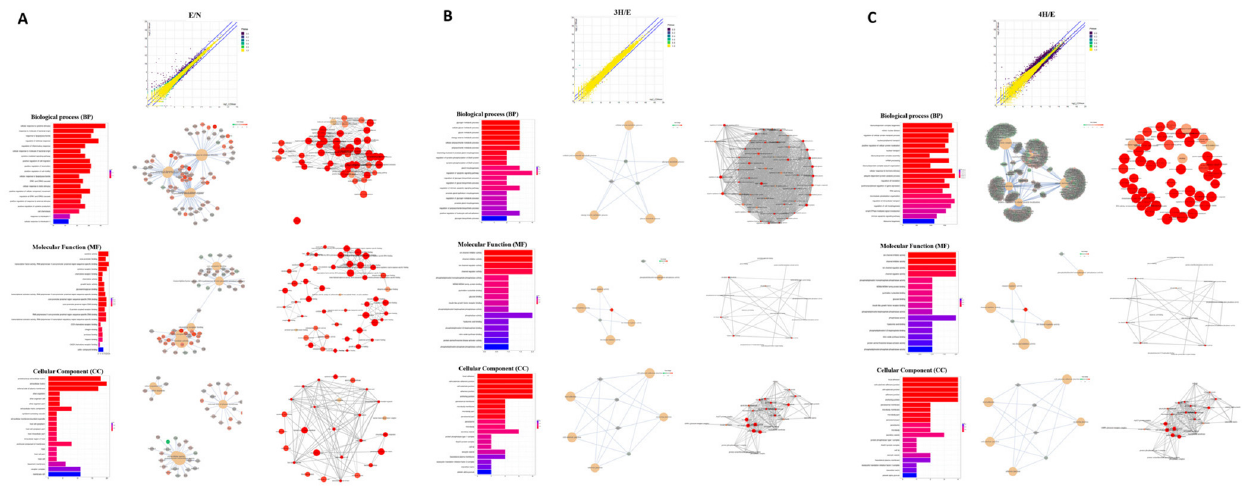
Figure 2. GO annotations of unigenes in transcriptome profile. ( A ) E compared to N. ( B ) 3H compared to E. ( C ) 4H compared to E.